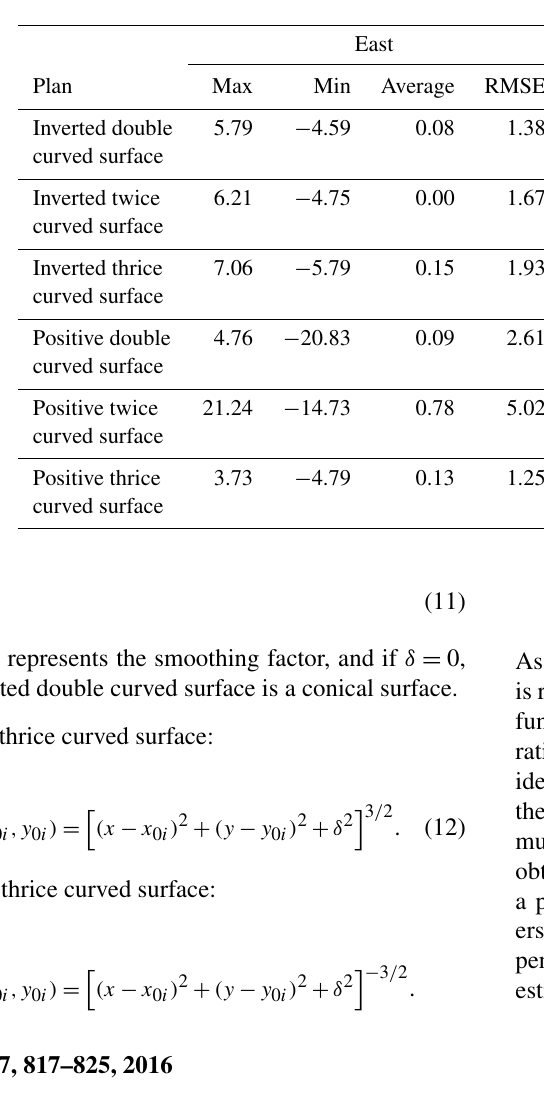
Table 2. External inspection accuracy of different kernel functions (mmyr − 1